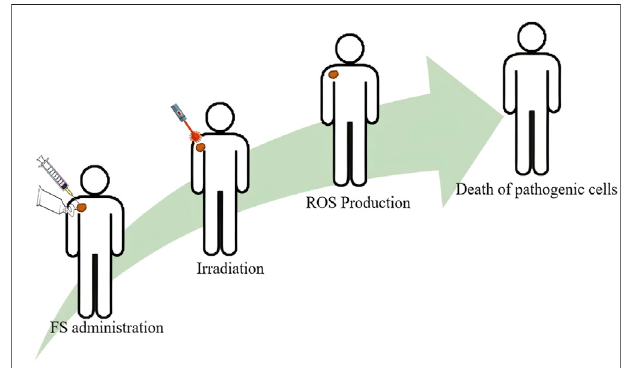
FIGURE 2 | Basic Principle of Photodynamic Therapy (Source: Authors own elaboration).